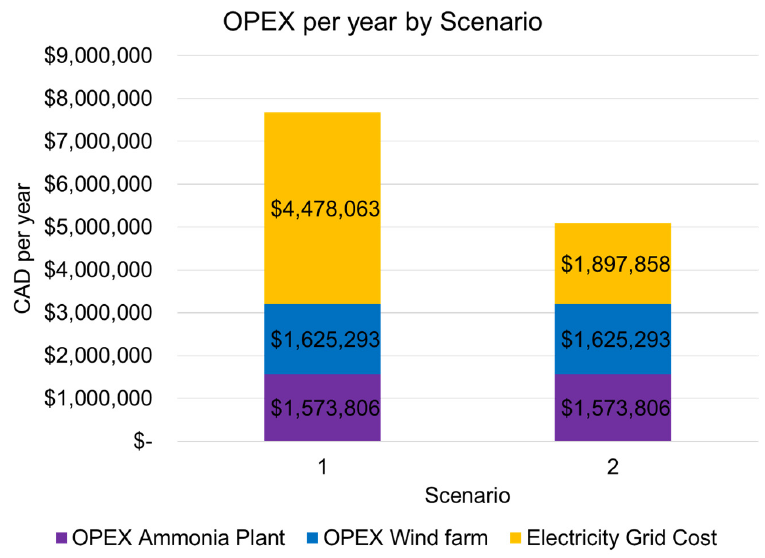
Figure 9. Annual OPEX of the P2A system for Scenarios 1 and 2.